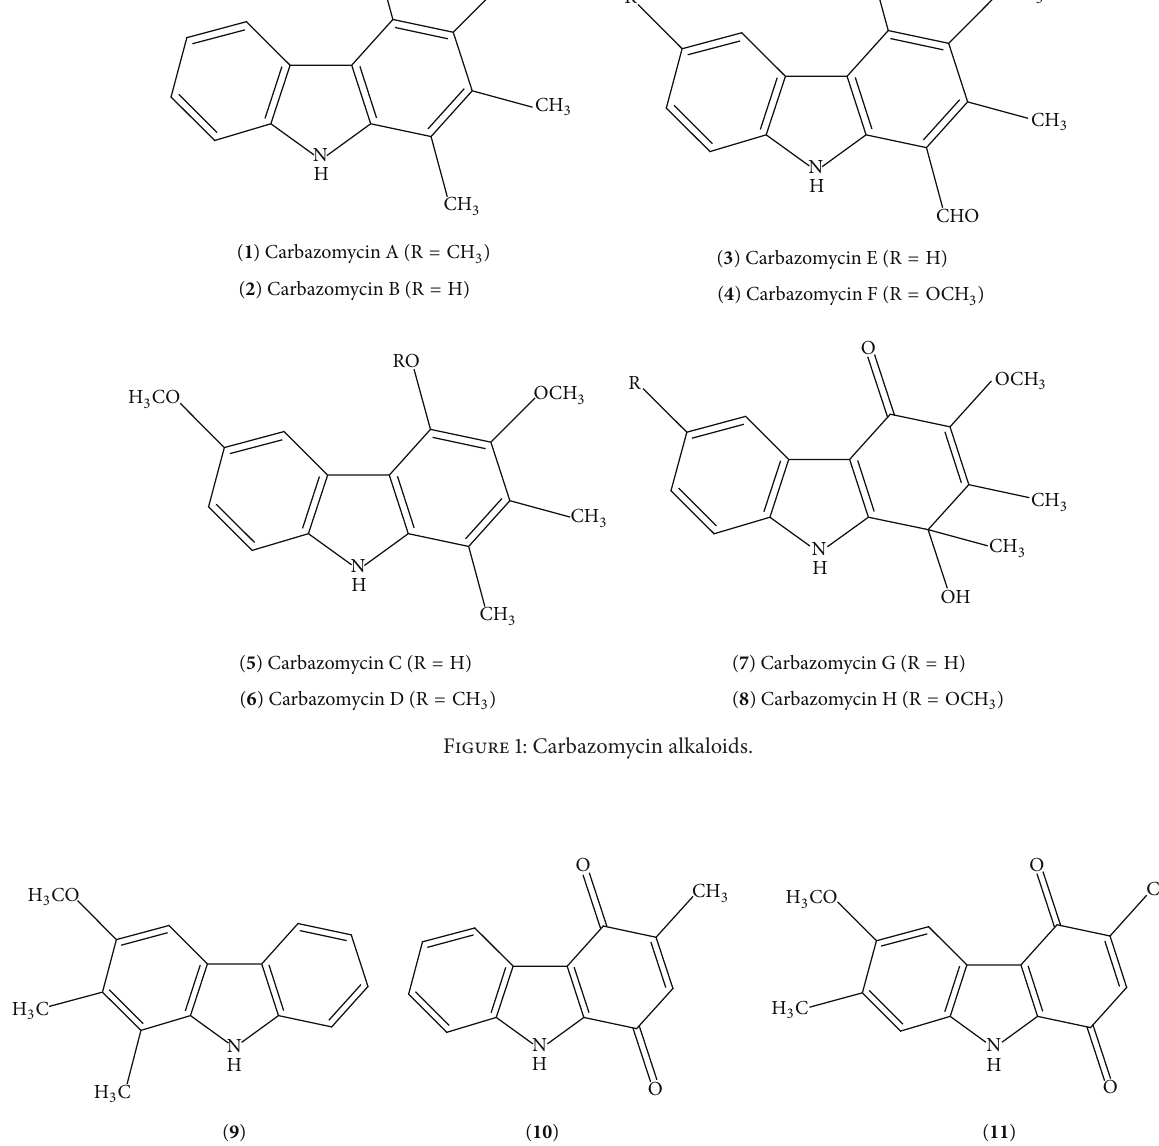
Figure 2: Structure of Deoxycarbazomycin B ( 9 ), 3-methyl-1 H -carbazole-1,4(9 H )-dione, Murrayaquinone A ( 10 ), and 6-methoxy-3,7- dimethyl-1 H -carbazole-1,4(9 H )-dione ( 11